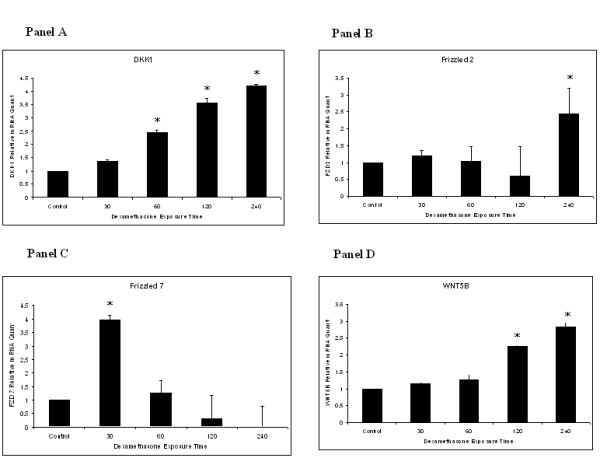
Dexamethasone elicited alterations in developmental gene expression. Confirmation of the microarray identified alterations in expression of DKK1, frizzled 2, frizzled 7 and WNT5B (Panels A, B, C and D respectively.) by quantitative real time PCR. All expression values were normalised to 18S rRNA. All measurements were completed in triplicate. Data are quoted relative to control. (* P < 0.05)